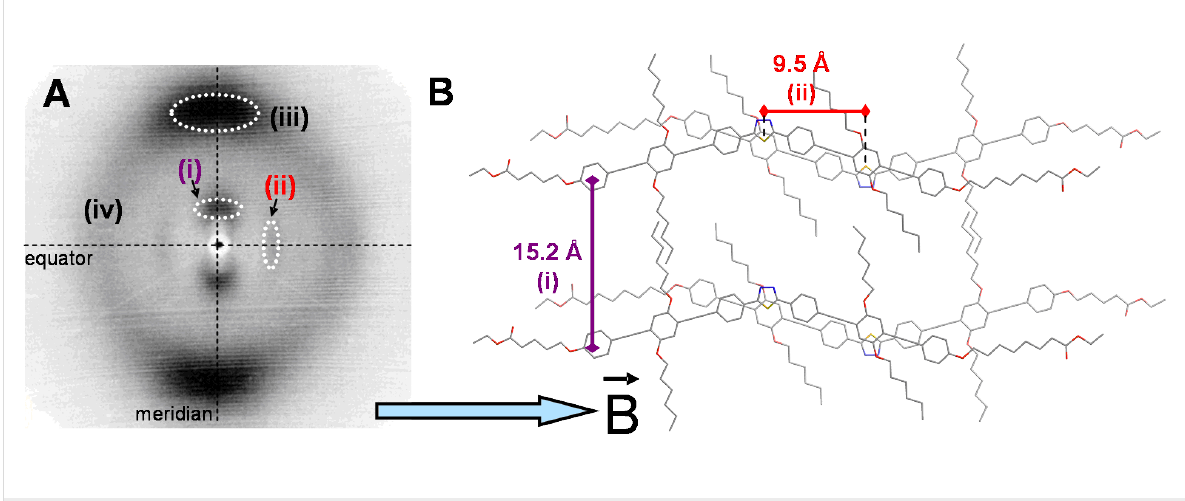
Figure 6: X-ray study of nematic mesophases from V-shaped mesogens. A: Diffraction pattern of 2c at 70 °C. B: Model of the local molecular order and characteristic distances corresponding to reflections (i) and (ii).